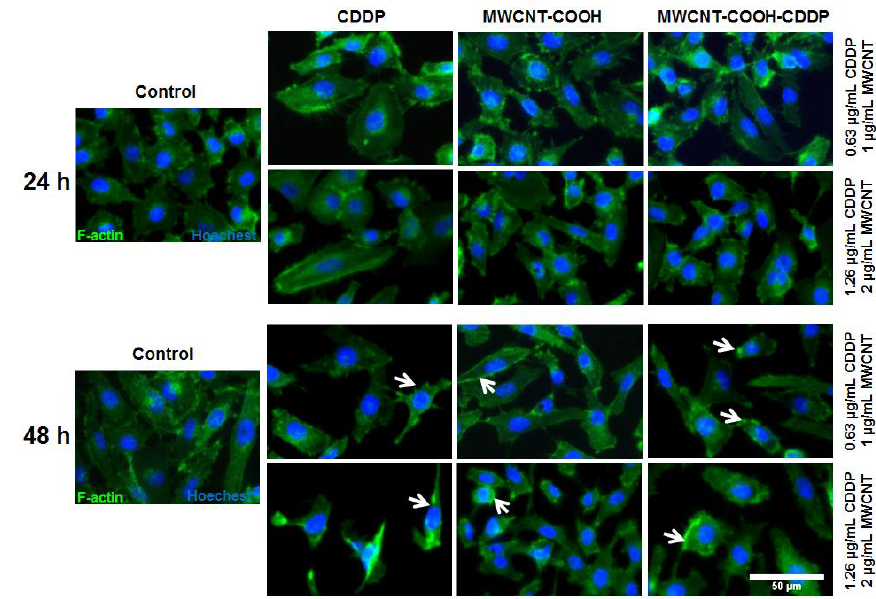
Figure 8. Immunofluorescence labelling of MDA-MB-231 cells after 24 h and 48 h of exposure to 1, 2 µg/mL MWCNTs and 0.63, 1.26 µg/mL CDDP. Green fluorescence (Alexa Fluor 488 phalloidin dye) indicates F-actin filaments and blue labelling (Hoechest) corresponds with cells nuclei. White arrows indicate filaments actin modifications. Scale bar: 50 µm.